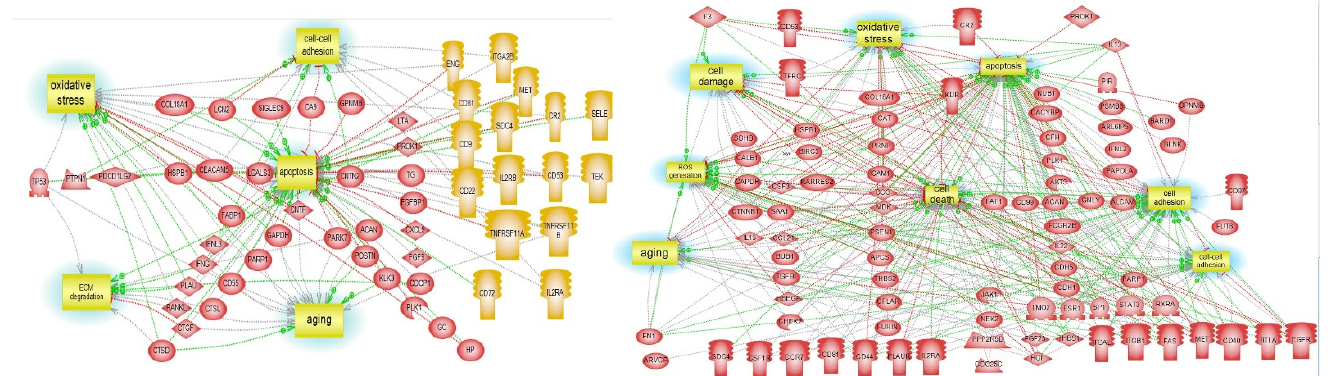
Figure 6. DE-protein pathway studio analyses in Braak III-IV and Braak V-VI. AD pathways generated by DE-proteins in Braak III-IV (panel A) and Braak V-VI DE-miRNA (panel B).